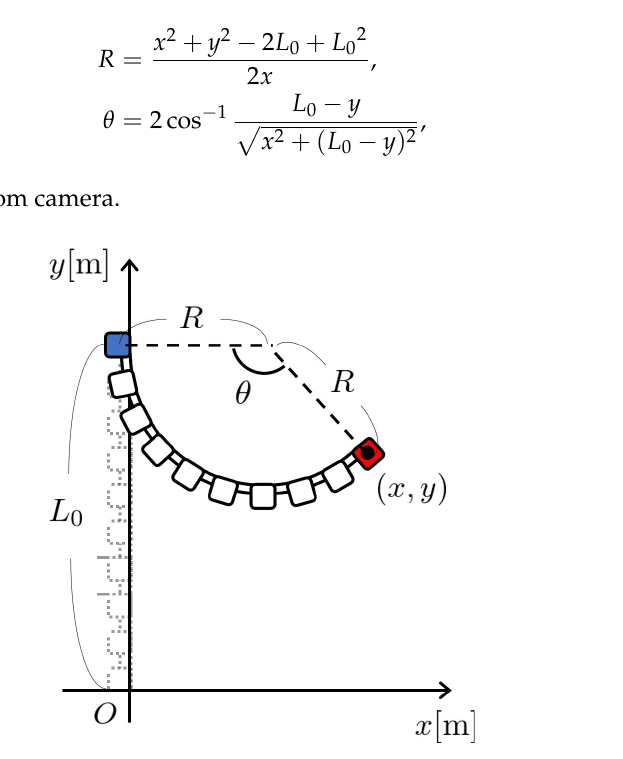
Figure 11. The model for computing the output